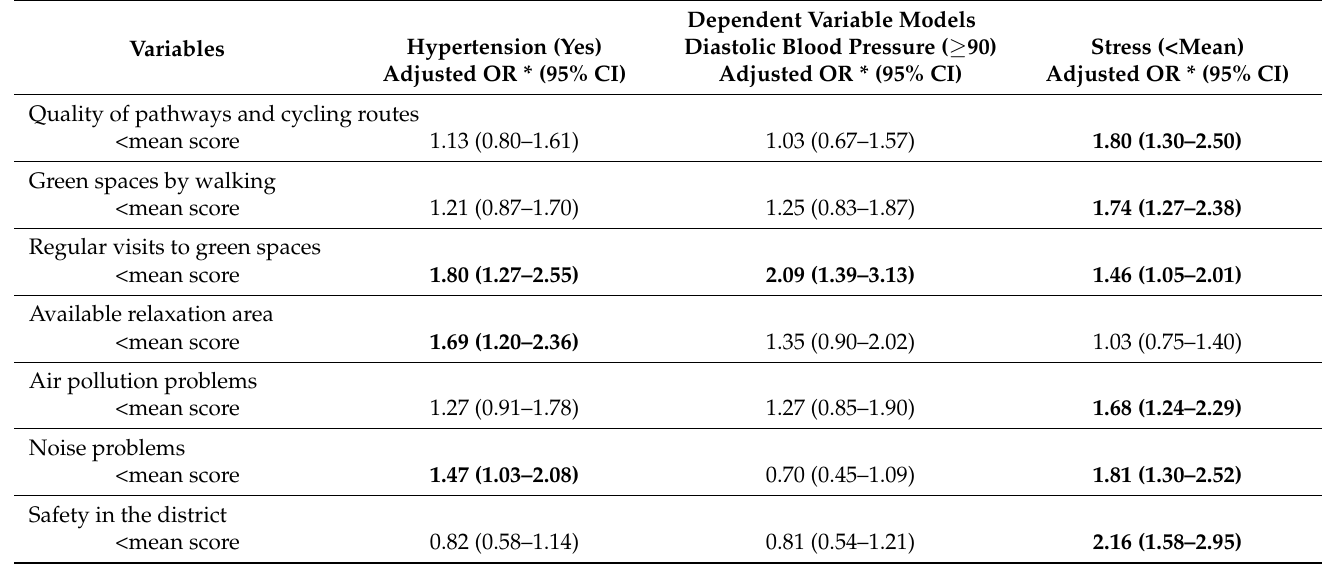
Table 4. Multivariable logistic regression models of neighborhood quality items on hypertension, diastolic blood pressure, and stress in 45–64-year-old